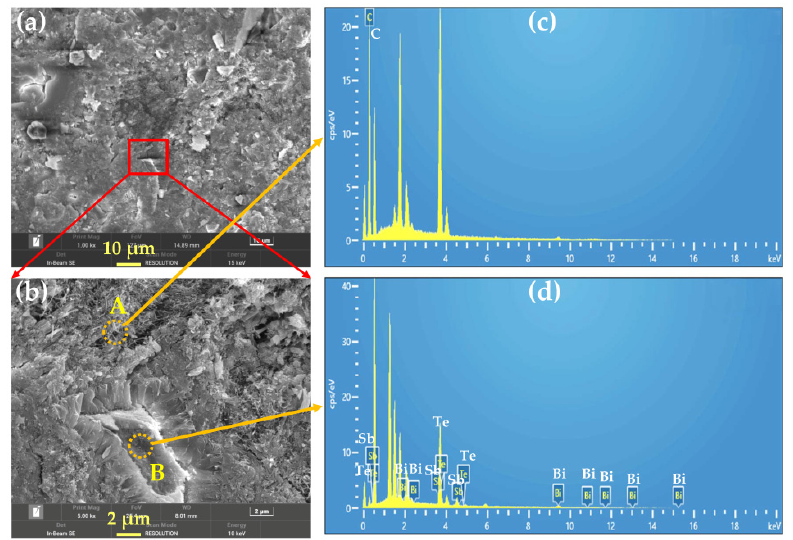
Figure 10. ( a ) SEM image and ( b ) enlarged SEM image of Bi 0.5 Sb 1.5 Te 3 /CNTs co ‐ reinforced cement composites at 0.6 vol.% Bi 0.5 Sb 1.5 Te 3 . ( c , d ) EDS patterns of the point A and B in ( b ), respectively.